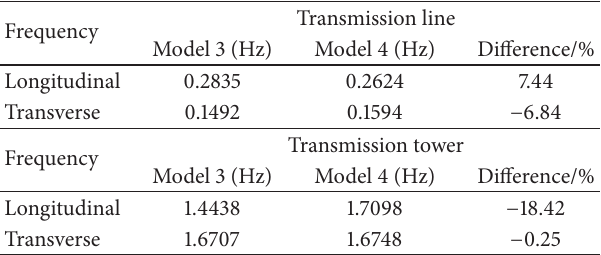
tower and line is assumed to be 2% and 1%,